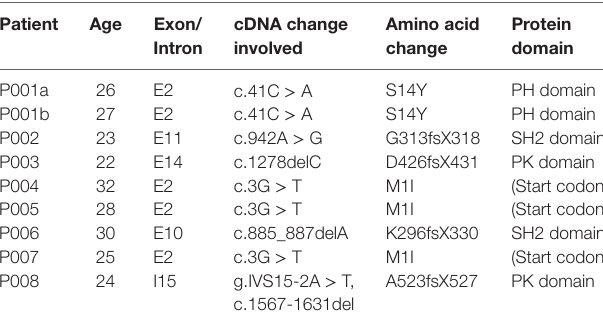
TaBle 1 | Bruton’s tyrosine kinase mutations of the nine XLA patients.